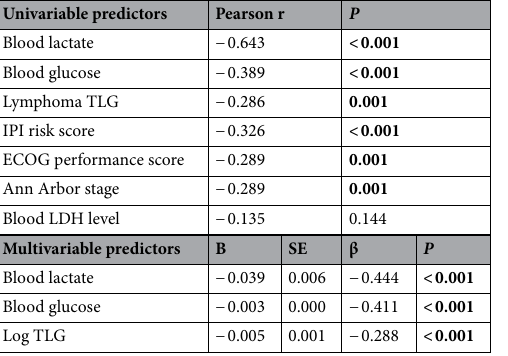
Table 3. Clinical and PET predictors of log temporal SUVave. Significant values are in bold. ECOG, Eastern Cooperative Oncology Group; IPI, International Prognostic Index; LDH, lactate dehydrogenase; TLG, total lesion glycolysis; S.E., standard